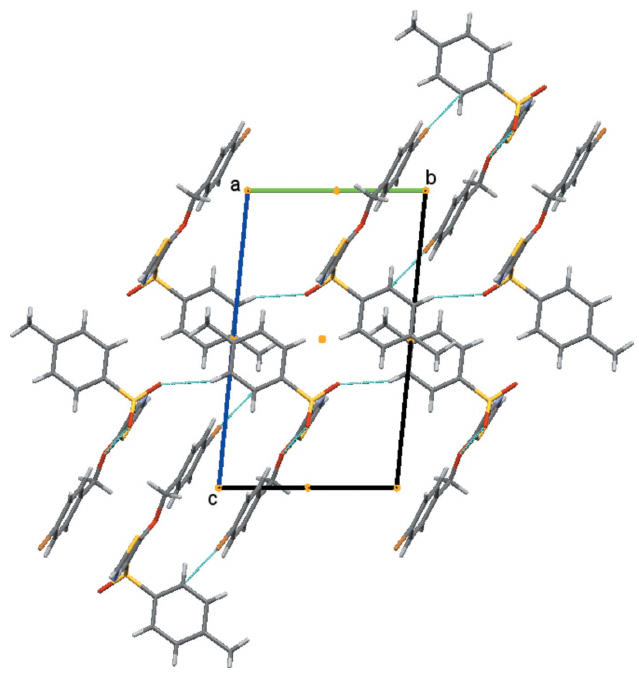
Figure 2 Packing diagram of the title compound viewed down [100].